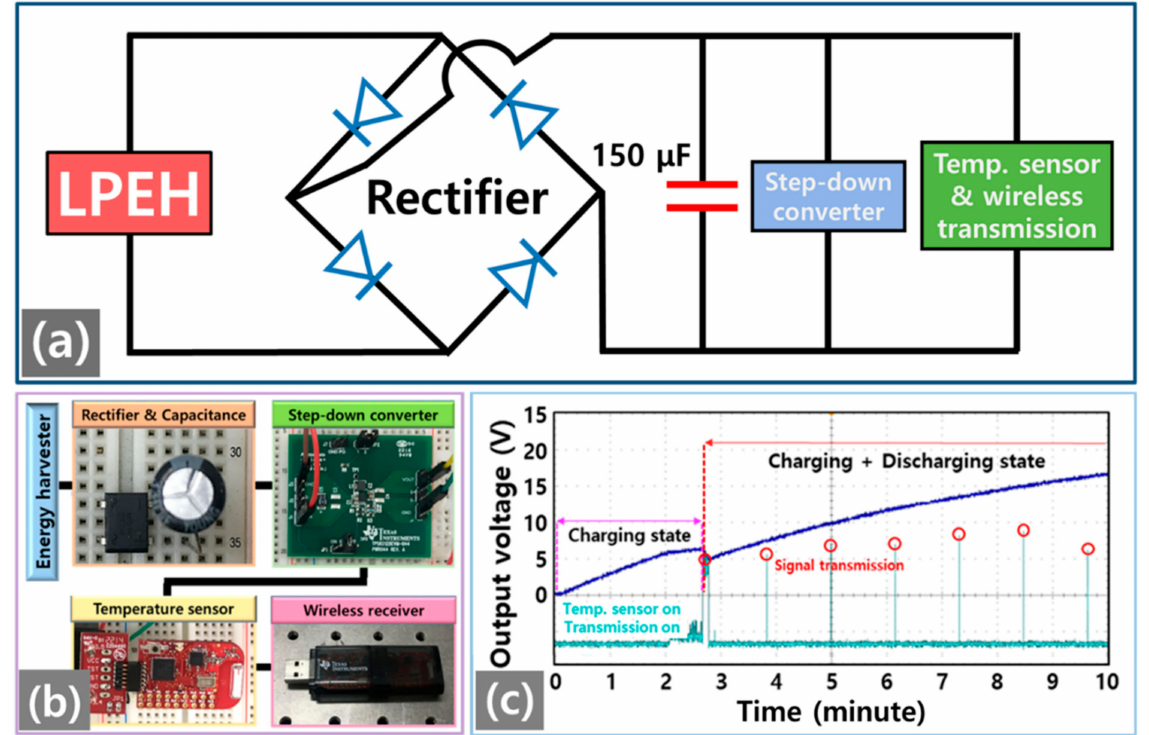
Figure 4. ( a ) Circuit diagram of self-powered wireless temperature monitoring system powered with the LPEH in a magnetic field of 250 µ T. ( b ) Photograph images of the self-powered wireless temperature monitoring system (see Supporting Information Figures S1 and S2). ( c ) Characteristics of the self-charging voltage that drives the temperature sensor and radio-frequency (RF) transmission using a capacitor of 150 µ F with the LPEH in a magnetic field of 250 µ